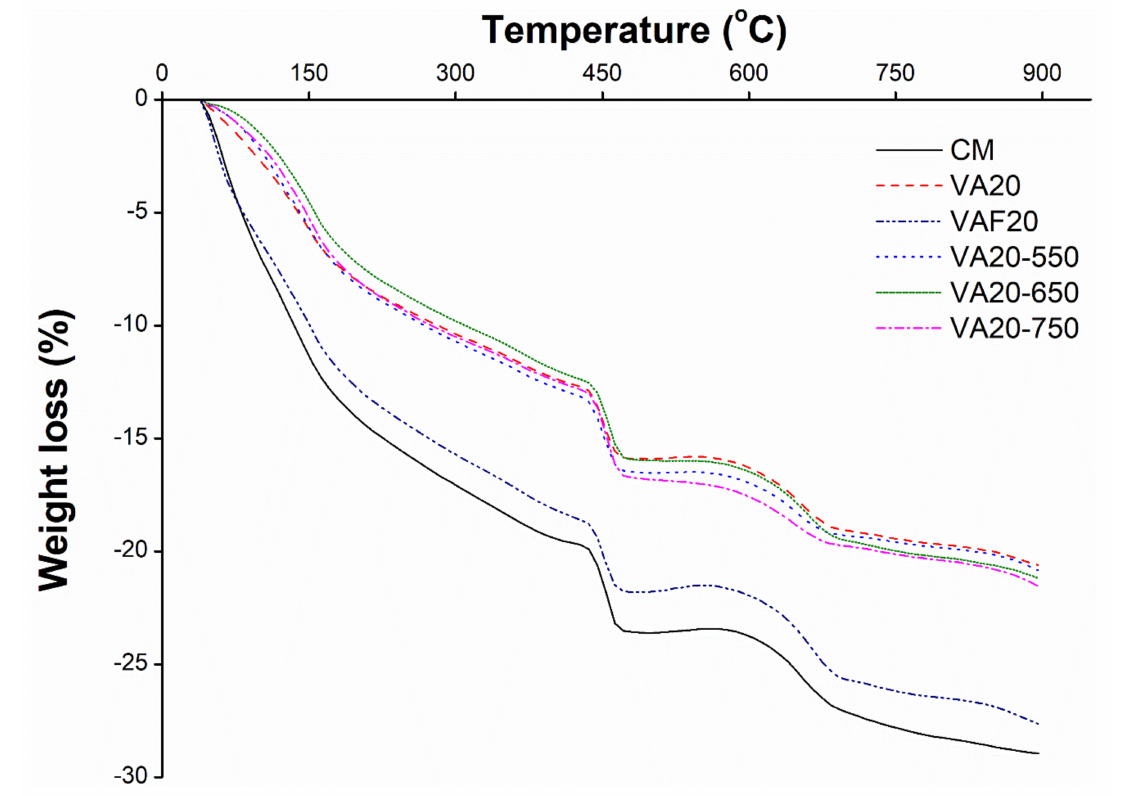
Figure 10. TGA results for control mortar (CM) paste and pastes containing different volcanic ashes at 91